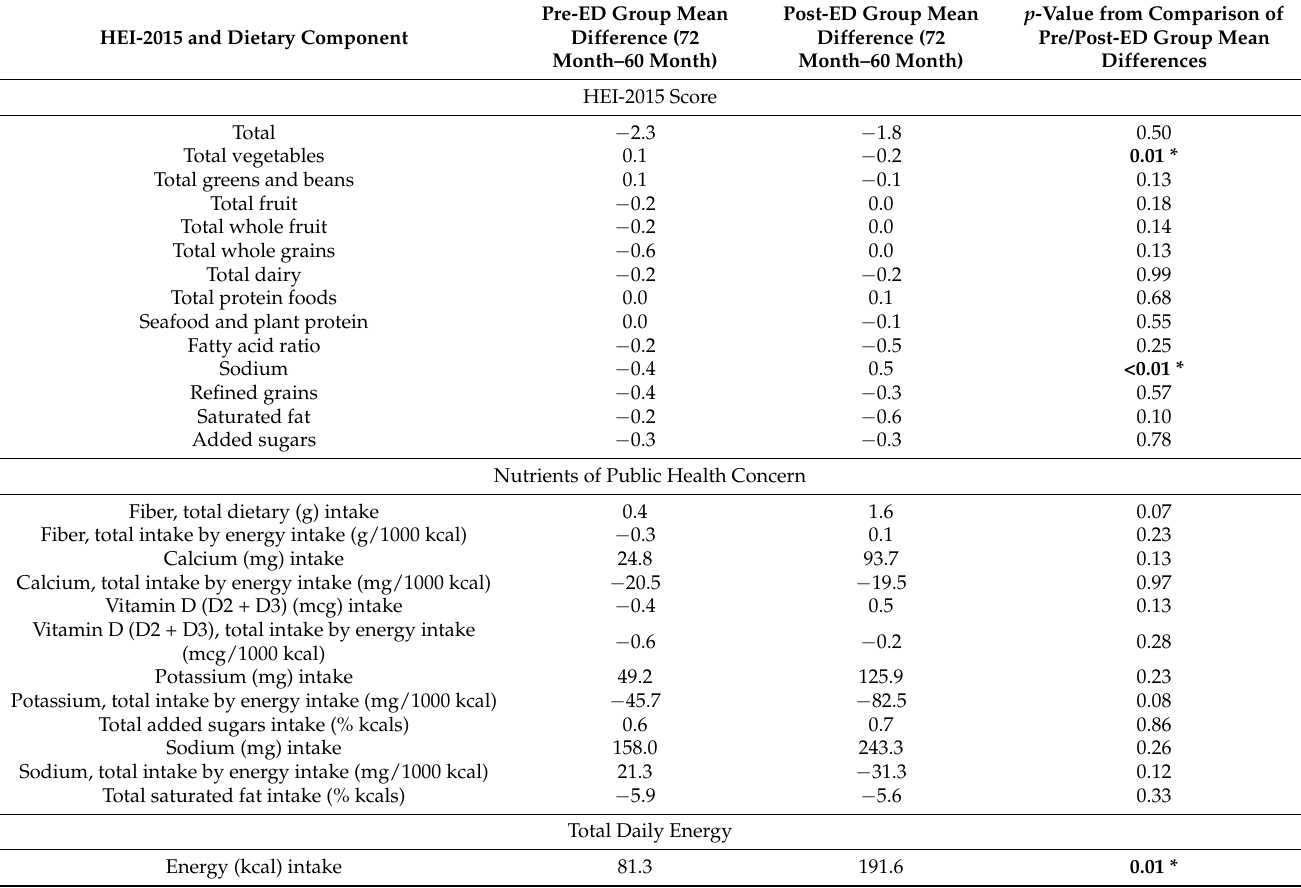
HEI sodium component scores indicated lower sodium intake given energy. However, this analytic approach also indicated significant differences in intakes of refined grains ( p = 0.03) and total saturated fat ( p = 0.04), with the post-ED group exhibiting higher scores for refined grains and lower scores for saturated fats than the pre-ED group. Among the seven nutrients of public health concern considered for comparison, significant differences were identified in vitamin D intakes, both in total grams ( p < 0.01) and in grams per 1000 kilocalories ( p < 0.01), with the post-ED group exhibiting higher intakes than the pre- ED group in both cases. Additionally, a significant difference was identified in intakes of saturated fat as a percentage of dietary energy ( p = 0.01), with the post-ED group consuming a slightly larger percentage than the pre-ED group. Table 3. Mean within-person differences between the 60- and 72-month interviews for Healthy Eating Index (HEI-2015) total and component scores a , energy and macronutrients, and nutrients of public health concern for the pre-emergency- declaration (pre-ED) and post-emergency-declaration (post-ED)